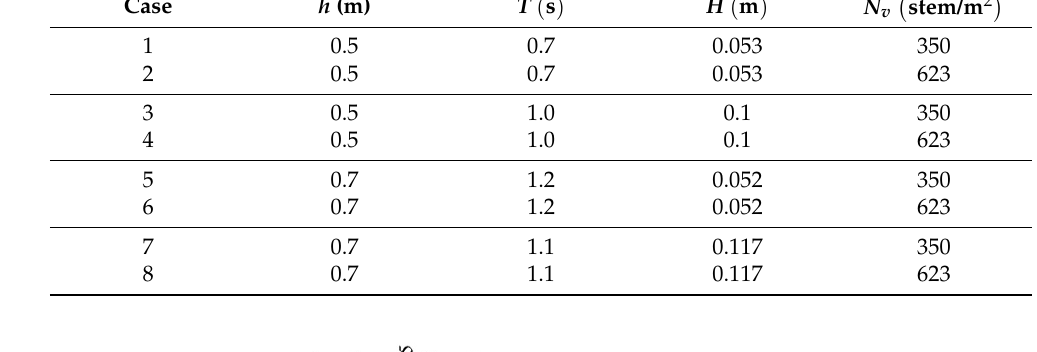
Figure 4. Experiment layout for the wave-vegetation interaction; green piles represent the vegetation patch. Table 1. Parameter setups for different experimental cases.